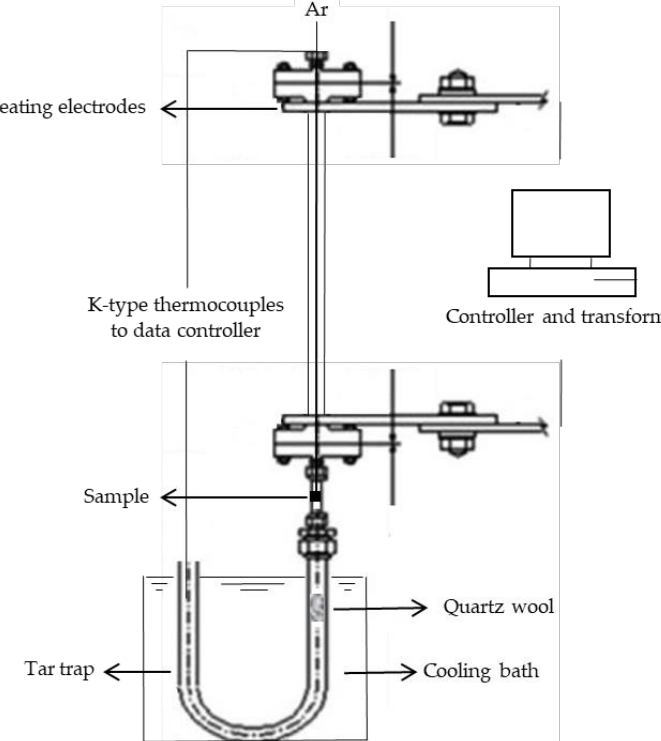
Figure 1. Fixed-bed reactor setup for the pyrolysis process.